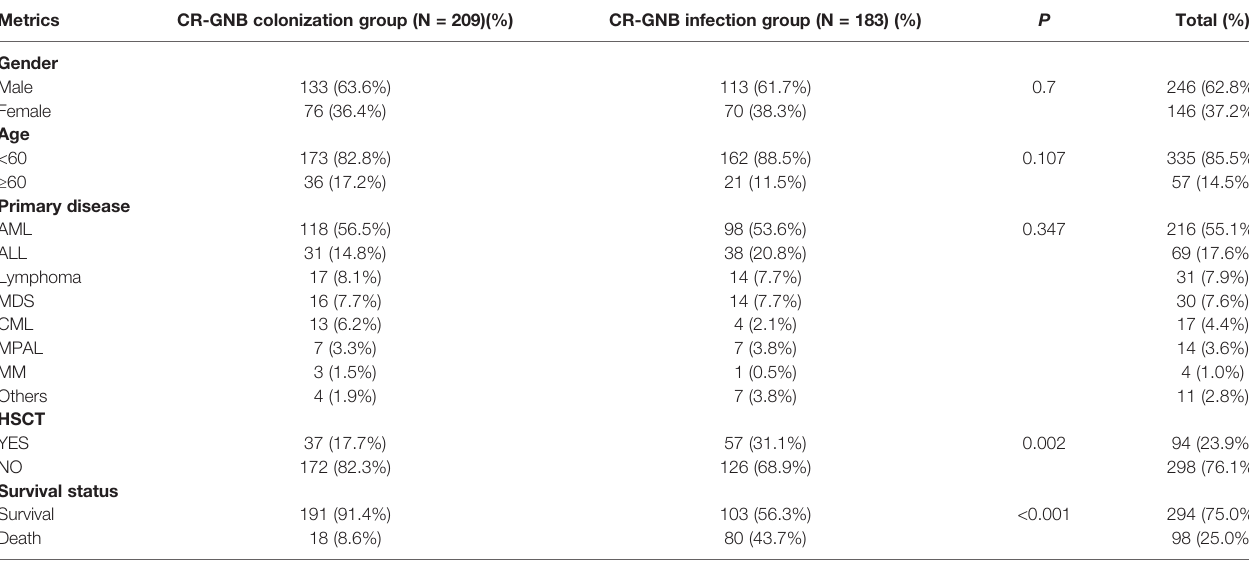
TABLE 1 | Basic clinical characteristics of HM patients with positive CR-GNB cultures in anal swab. Metrics CR-GNB colonization group (N =